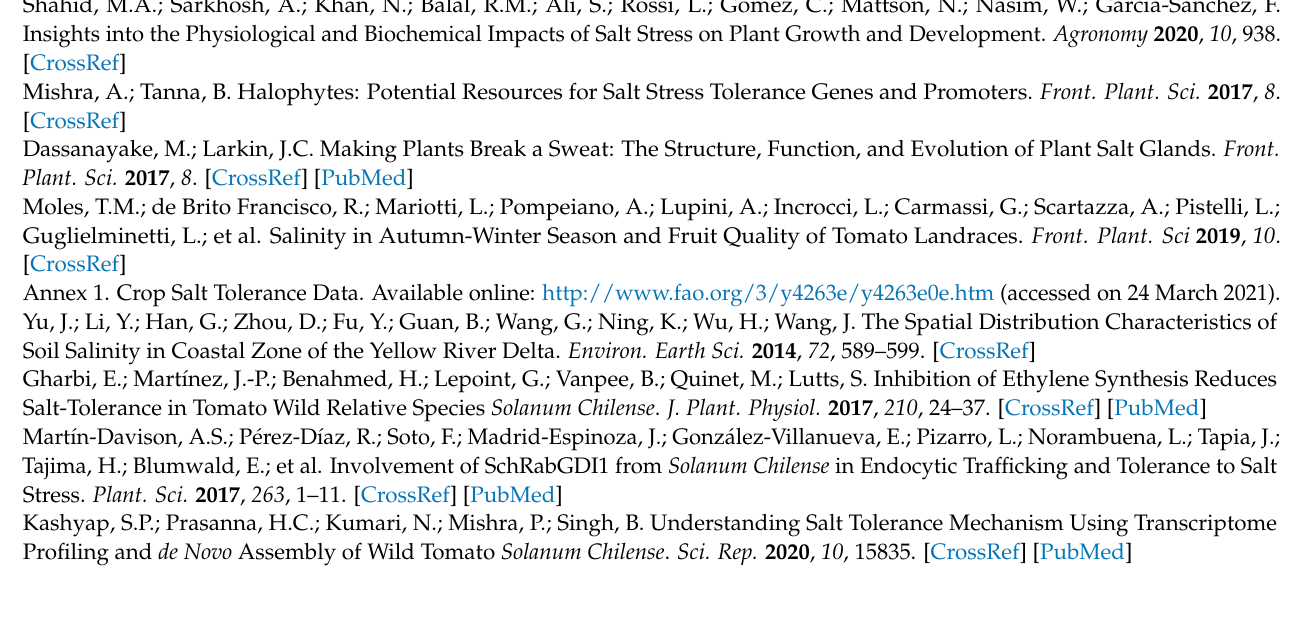
leaflets (e–h), Figure S4: Graph of the expression data shown in Figure 7a, Table S1: List of primers used in the study with details of amplicons’ size and amplification efficiency, Table S2: Statistical significance of the expression data shown in Figure